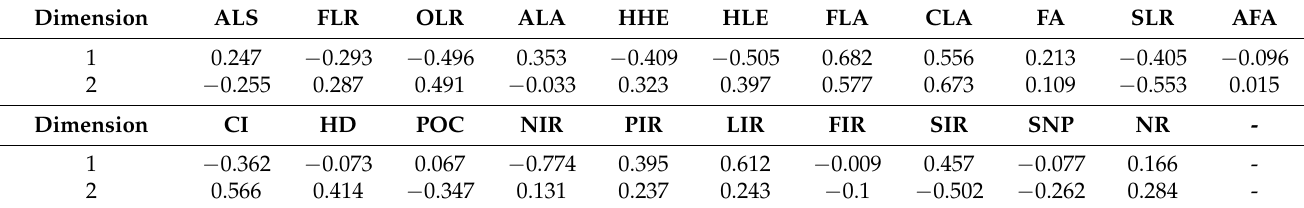
Table 3. CATPCA component loading results for the study